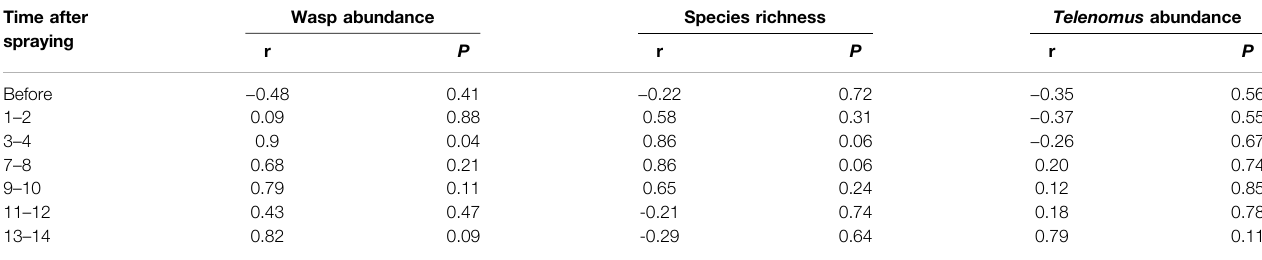
TABLE 4 | Pearson correlation between wasp community measures and distance from the vineyard on different days since spraying. N (cid:1) 5 (10, 20, 30, 40, 50 m from the vineyard ’ s edge) for each test. Time after Wasp abundance Species richness Telenomus abundance spraying r P r P r P Before −